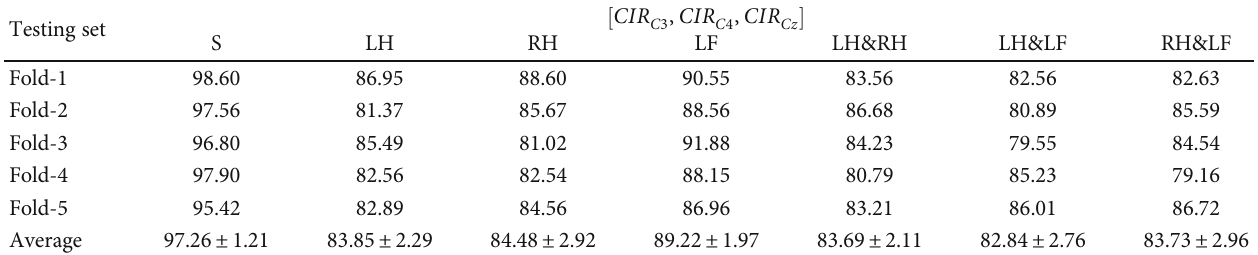
Table 4: Average classi fi cation accuracies for feature